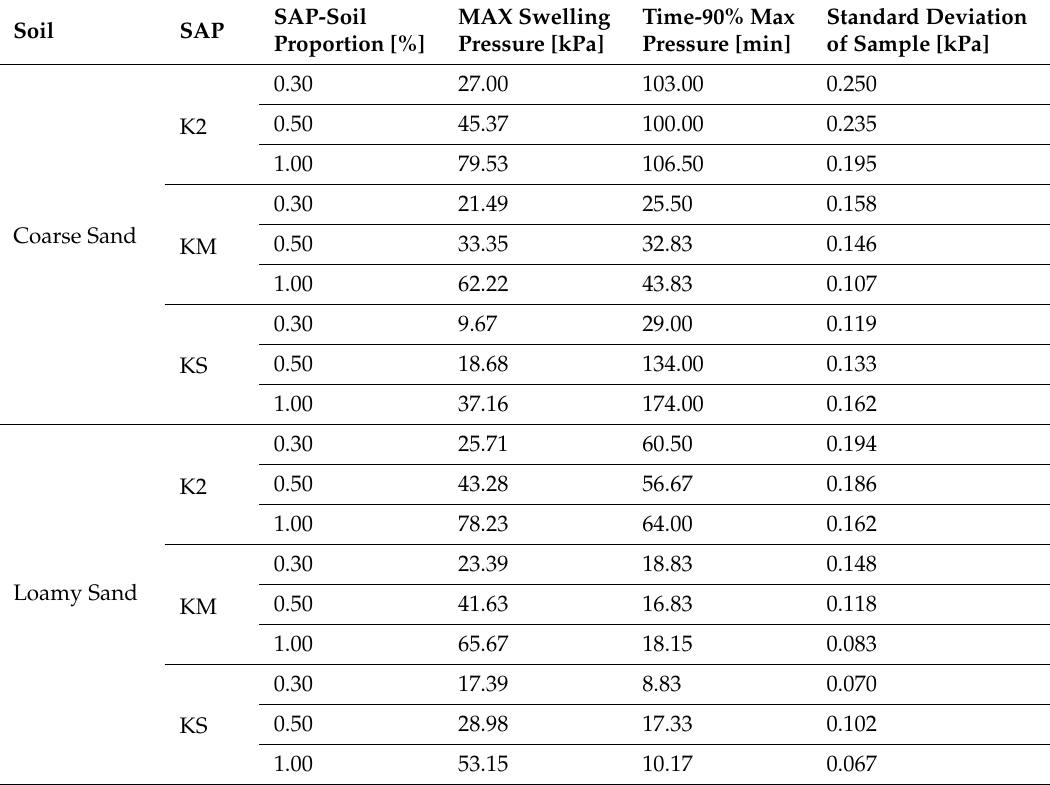
Table 2. Average maximum swelling pressure for tested